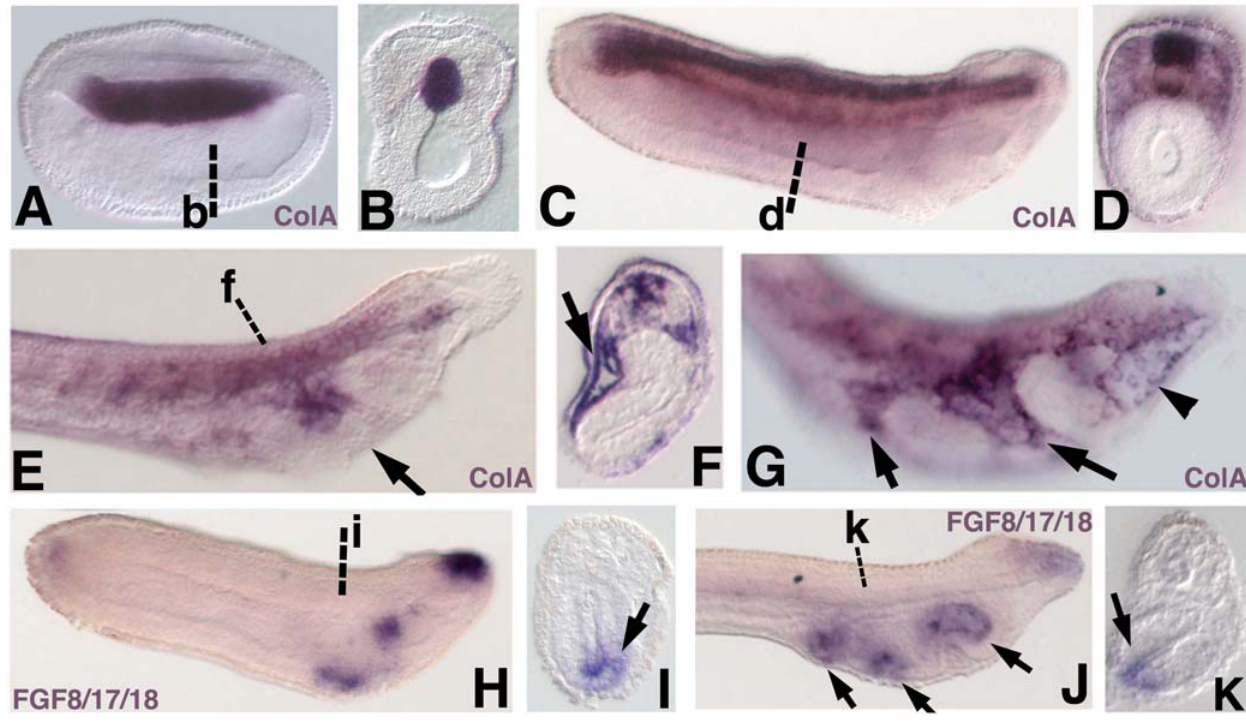
Figure 4. Expression of amphioxus ColA, and FGF8/17/18in late neurulae (15 h) and larvae. In all panels showing wholemount specimens, anterior is to the left. ( A ) ColA expression in the nascent notochord in late neurula. ( B ) Section at the level of b in A. ( C ) ColA expression in the neural tube and notochord in early larva (24 h). ( D ) Section through d in C showing weak expression in somitic mesoderm. ( E ) ColA expression in the mesoderm of the first pharyngeal arch (arrow) of 1.5d larva. ( F ) Section through the first pharyngeal arch at f in E showing mesodermal expression (arrow). ( G ) ColA expression in 2 gill slit larva. Strong expression is seen in the mesoderm of the first and second pharyngeal arches (arrows) and in individual cells of the right gut diverticulum (arrowhead). ( H ) FGF8/17/18 expression in dorsal anterior ectoderm and two patches of pharyngeal endoderm. ( I ) Section through the pharynx at i in H showing FGF8/17/18 expression in ventral endoderm (arrow). ( J ) FGF8/17/18 expression in the pharyngeal endoderm of 1.5d larva (arrows). ( K ) Section through k in J showing expression in ventral endoderm